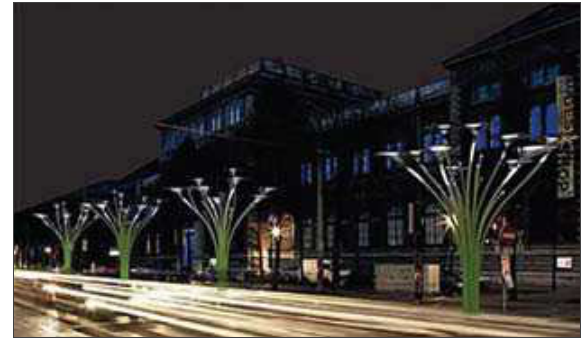
Fig. 23. r. Lovegrovesukurt's the solar tree,